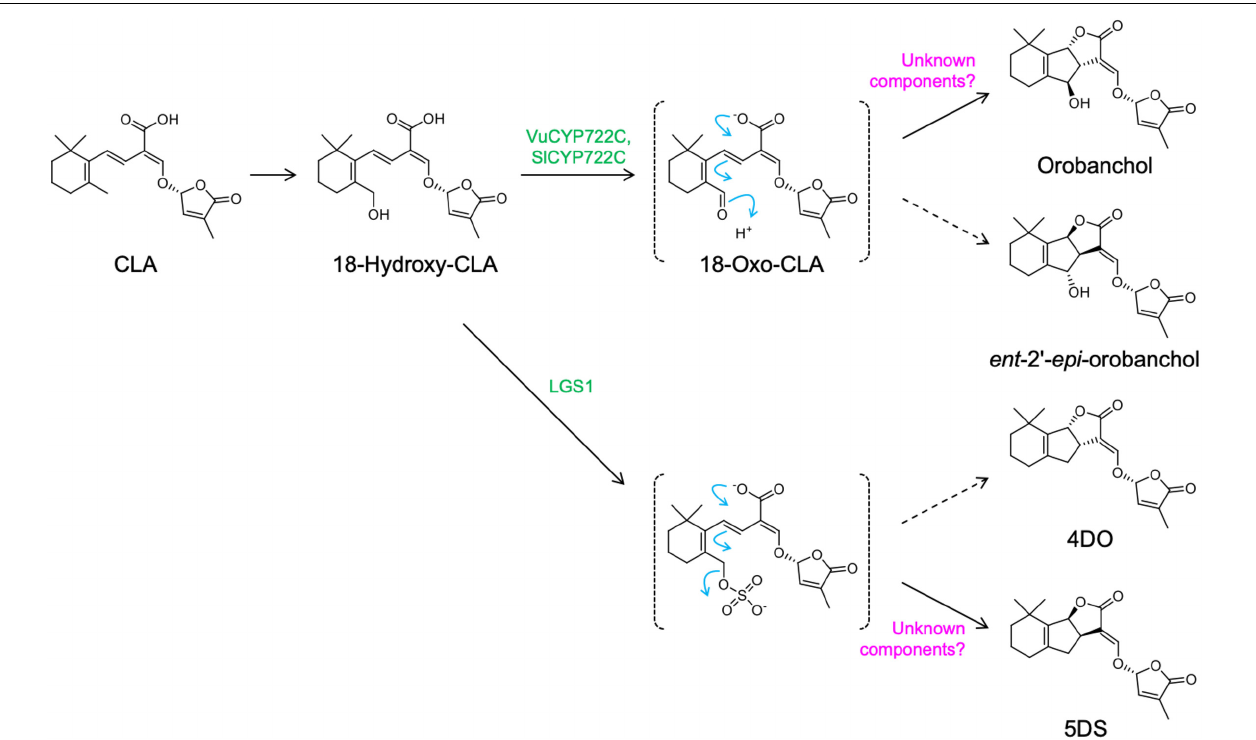
FIGURE 2 | Proposed mechanisms for generating canonical strigolactones with BC ring formation. Additional components may be necessary for the stereospecific conversion of 18-oxo-CLA to orobanchol and the sulfate ester of 18-hydroxy-CLA to 5DS (CLA, carlactonoic